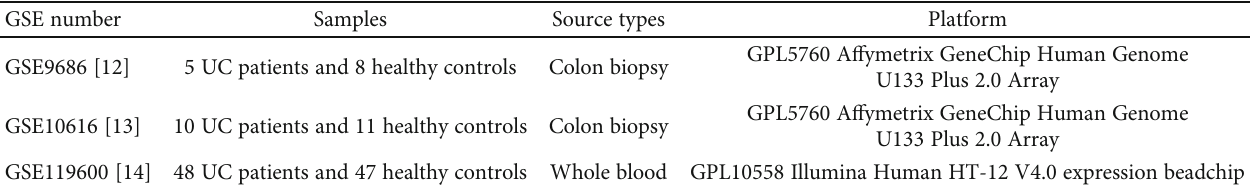
Table 1: Summary of the three genome-wide gene expression datasets that were used in this